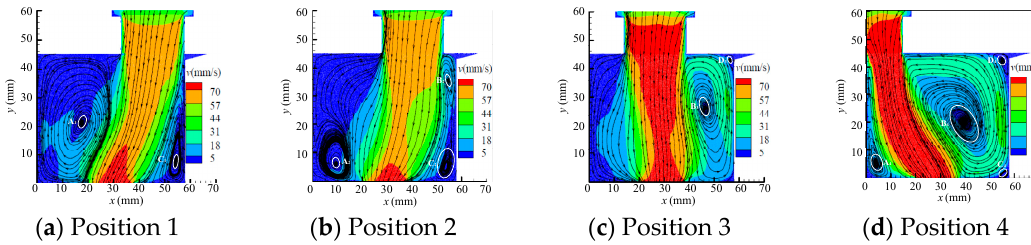
Figure 7. Velocity contours and streamlines with a pump inlet flow of 850 mL/min.